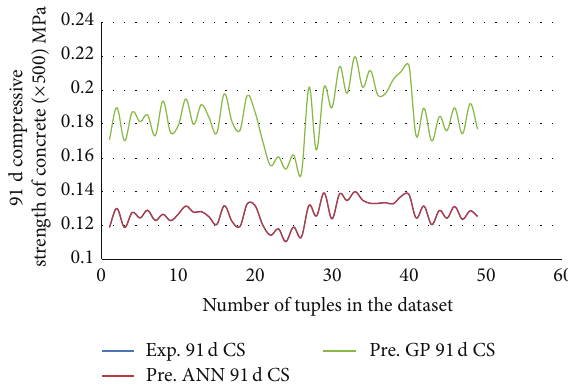
Figure 1: Comparison between actual and predicted values of 28 d compressive strength of concrete.